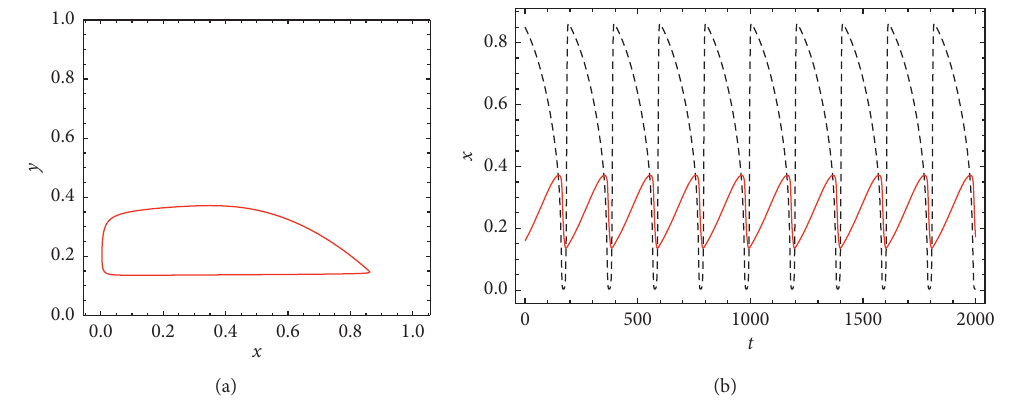
Figure 3: Numerical simulation of system (9).